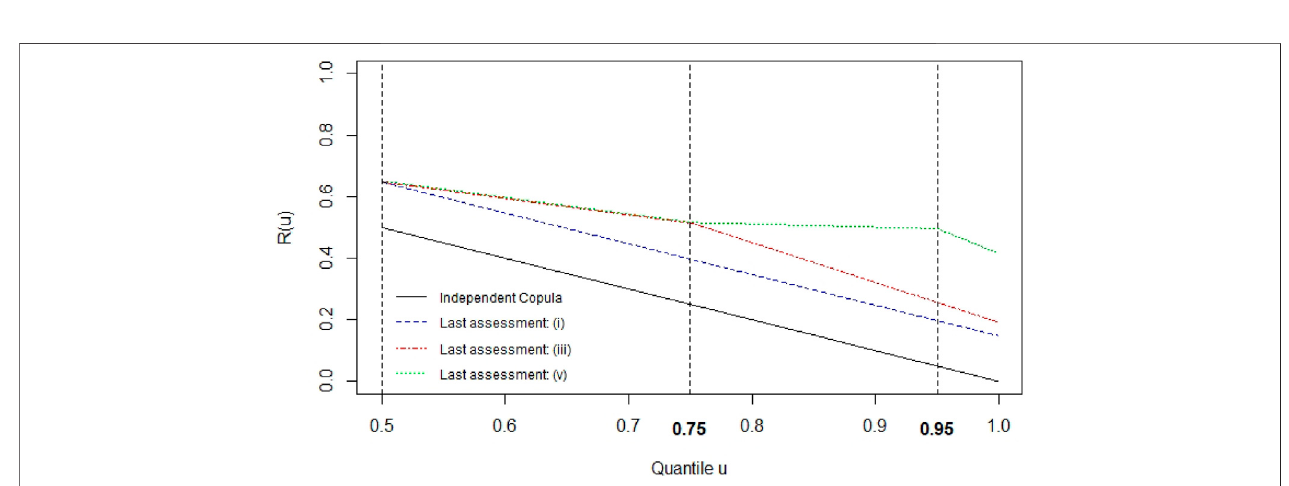
FIGURE 5 | R ( u ) when stopping quadrant re fi nements after assessments ( i ), ( iii ), ( v ).